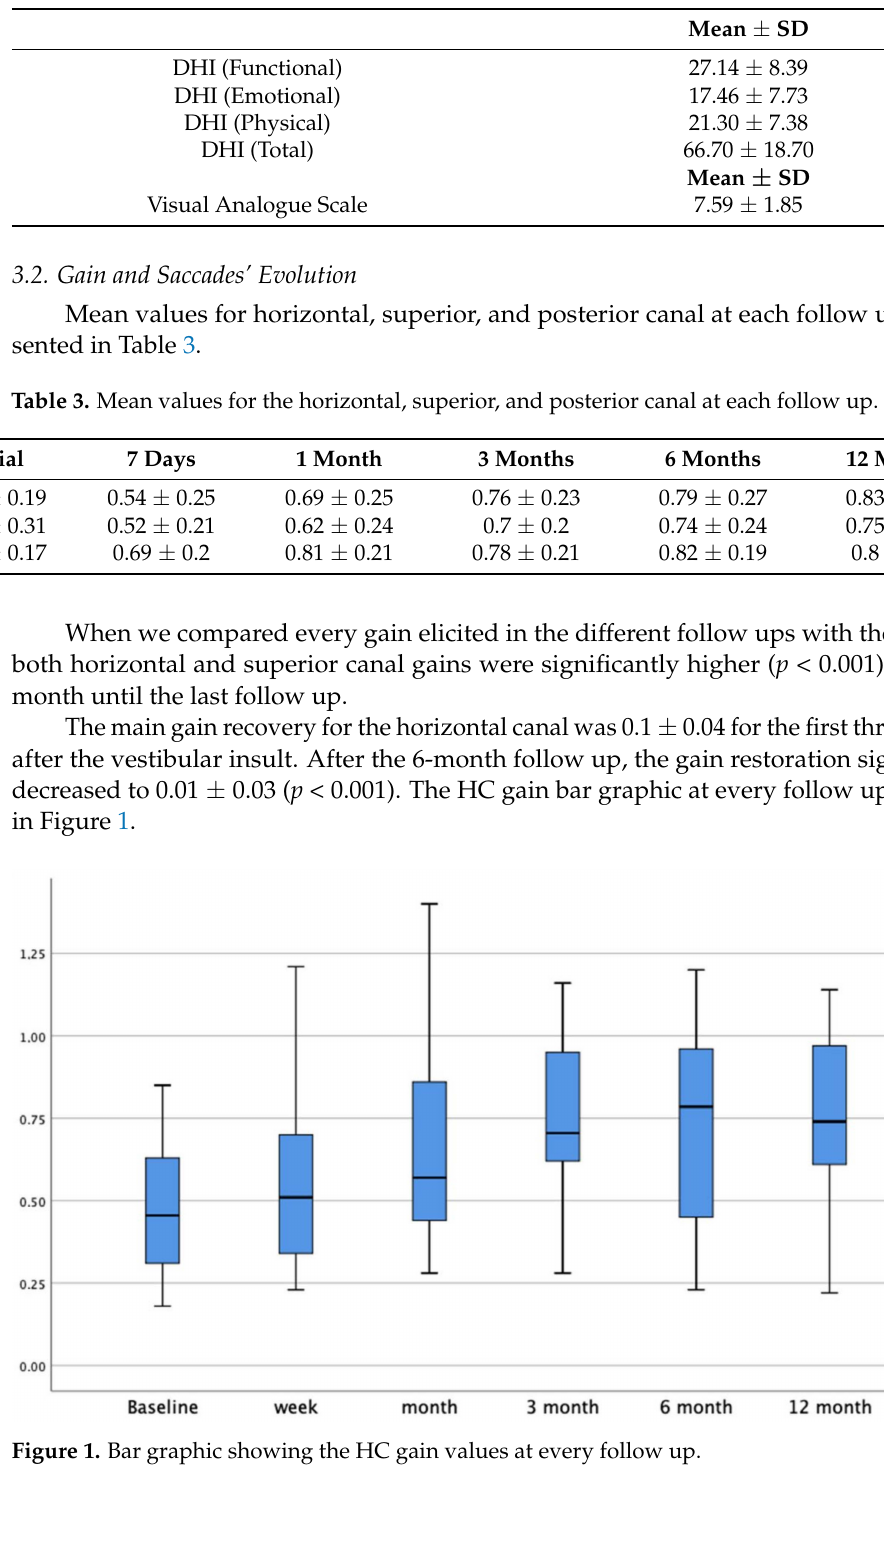
Table 2. Mean baseline values for baseline VAS and DHI.